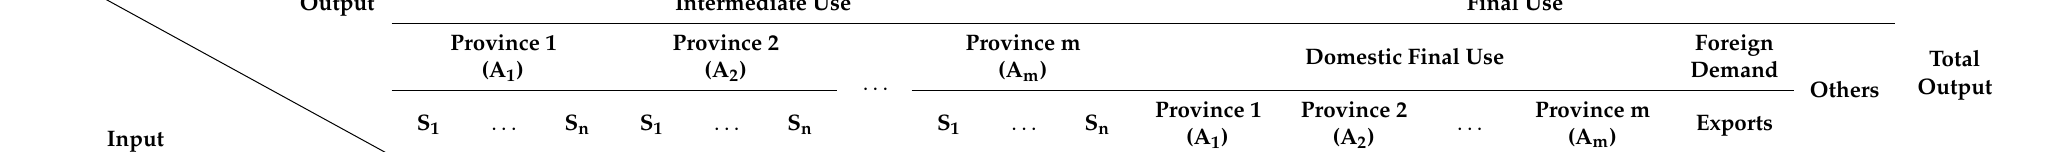
Table 1. The revised format of the MRIO